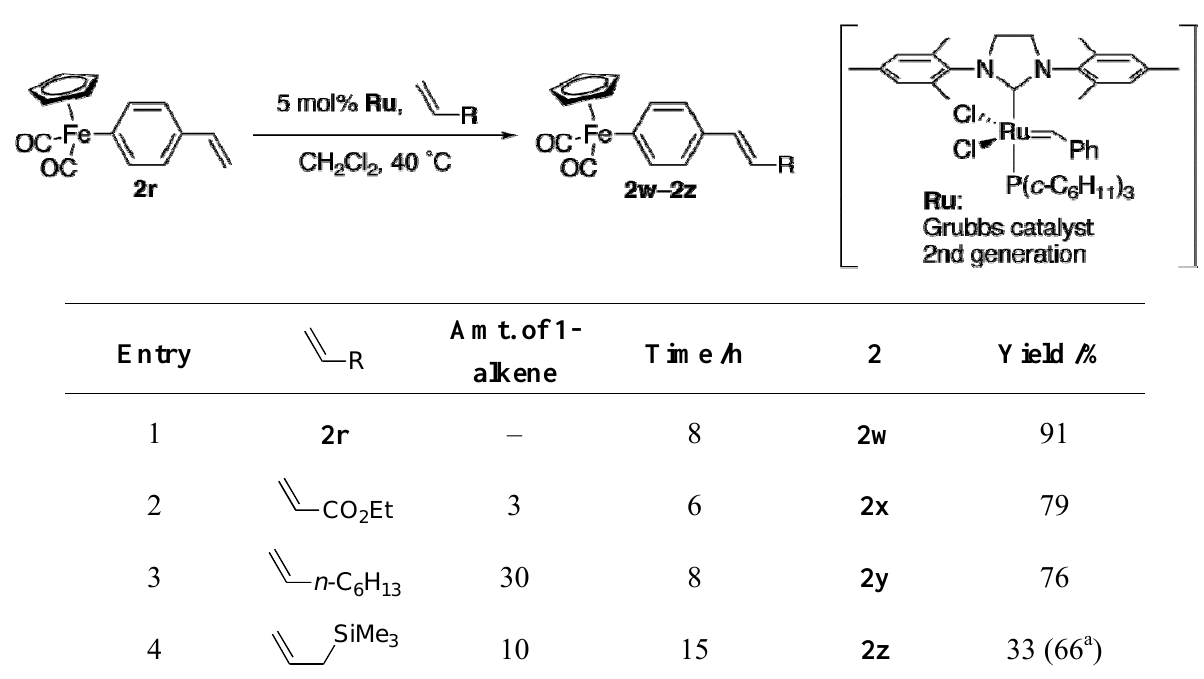
Table 7. Ruthenium-Catalyzed Metathesis of 2r